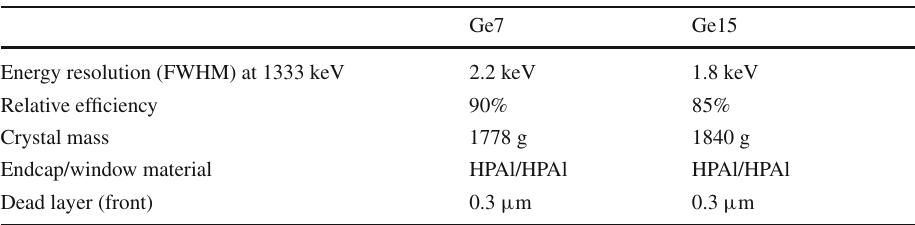
Fig. 4 Energy spectra in the energy intervals 20–800 keV ( a ) and 800–2700 keV ( b ) measured with the platinum sample over 8946 h (solid histogram) and without sample over 674 h (normalized to 8946 h, dots) by the ultralow-background HPGe-detector system. The energy of the γ peaks is in